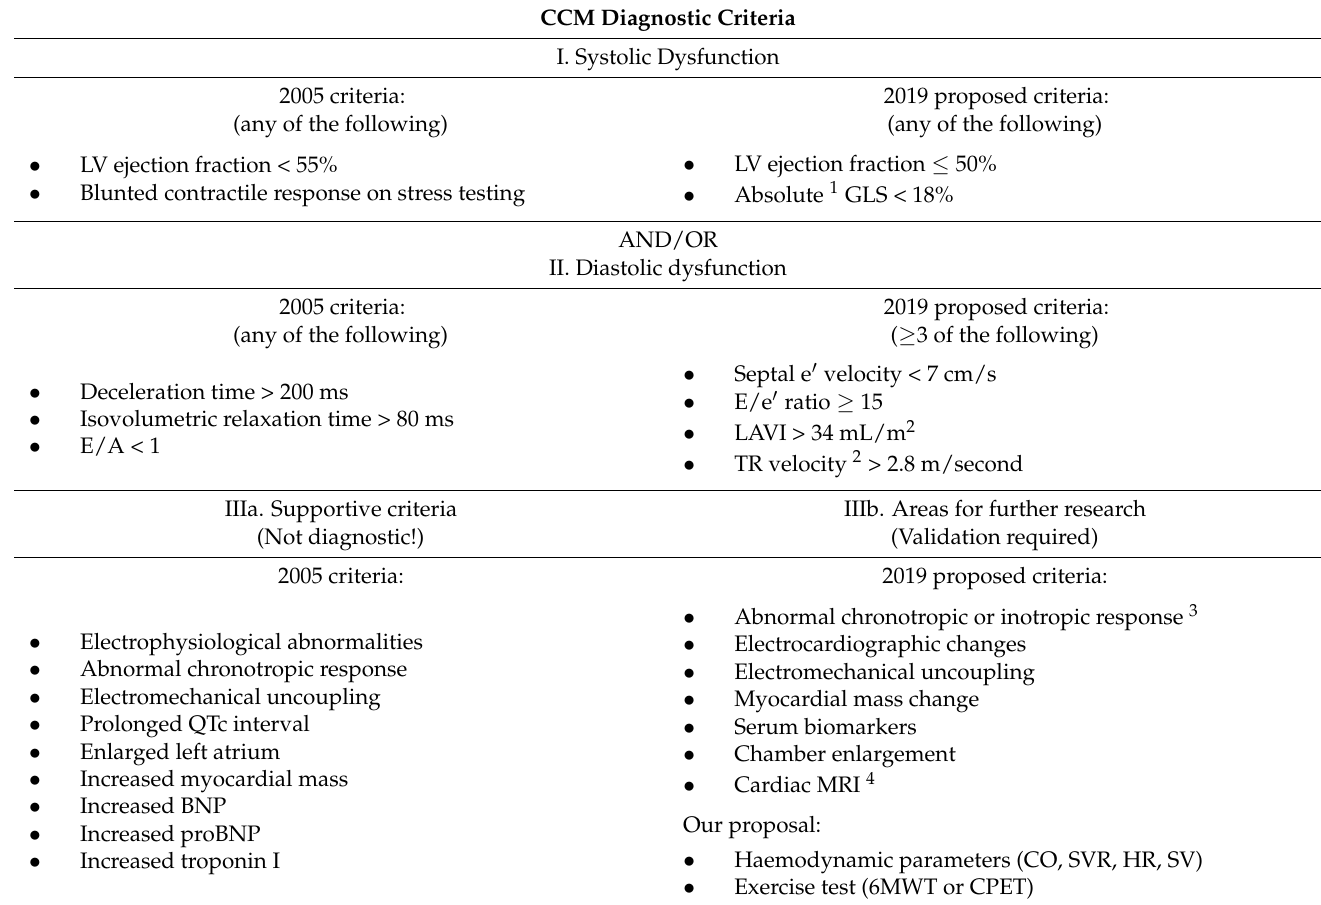
Table 1. Comparison of 2005 and 2019 CCM criteria [7]. GLS—global longitudinal strain; LV—left ventricle; E—early diastolic transmitral filling; A—late diastolic transmitral filling; e’—early diastolic mitral annular velocity; LAVI—left atrium volume index; TR—tricuspid regurgitation; QTc—corrected QT interval; BNP—brain natriuretic peptide;